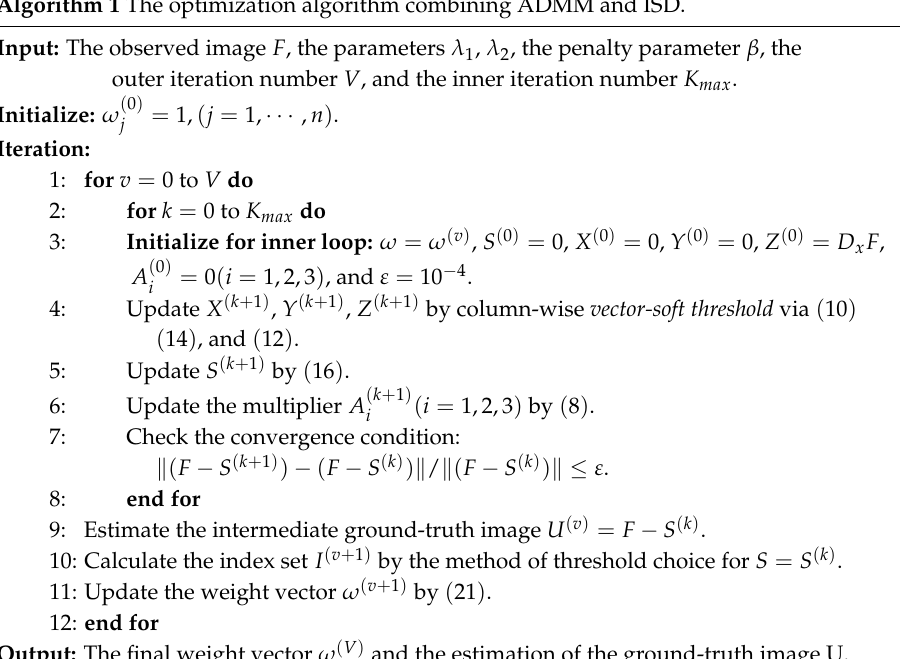
Algorithm 1 The optimization algorithm combining ADMM and